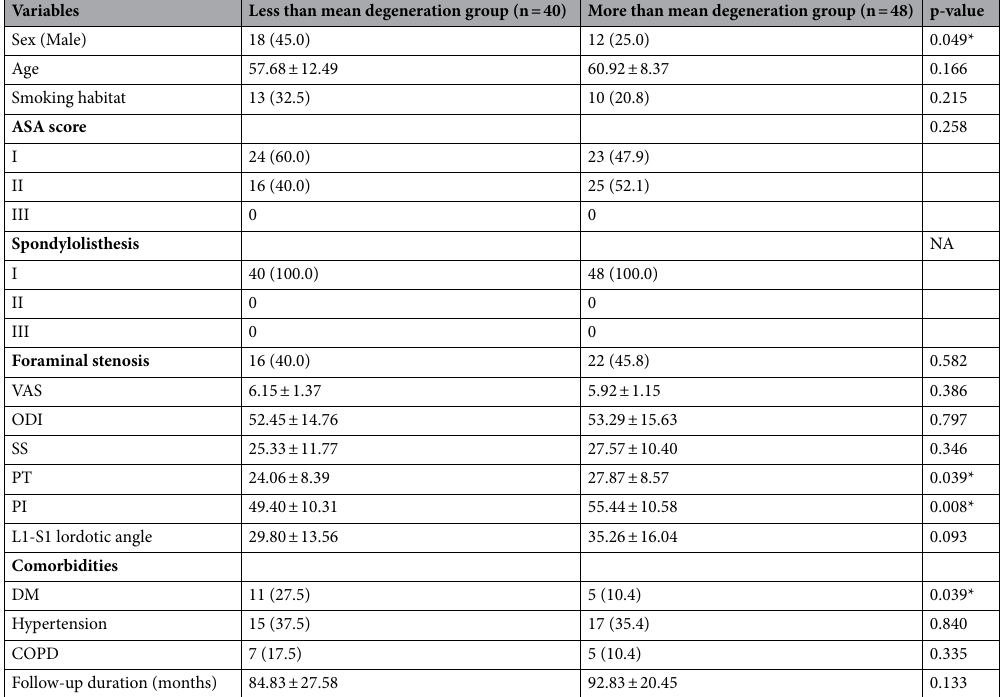
Table 2. Demographics and preoperative clinical characteristics of two facet joint degeneration groups. VAS Visual Analogue Scale, ODI Oswestry Disability Index, SS sacral slope, PT pelvic tilt, PI pelvic index. The data are expressed as number (%) or mean ± standard deviation. Statistical differences were examined by independent t-test or Chi-square test. *Indicated statistical significance.